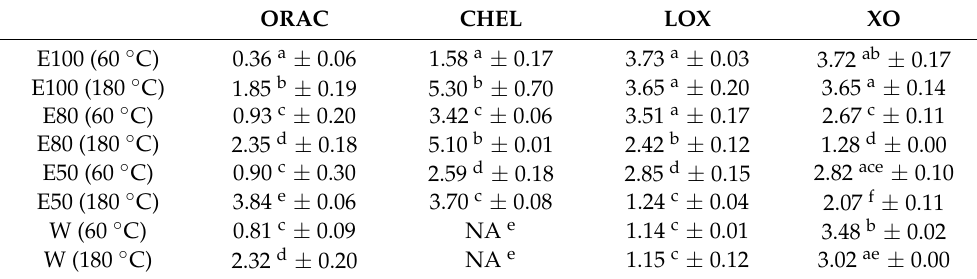
Values are presented as mean ± standard deviation ( n = 3) and evaluated by one-way ANOVA test (post-test: Tukey). Different superscript letters ( a–f ) in the same column denote significant differences at p <